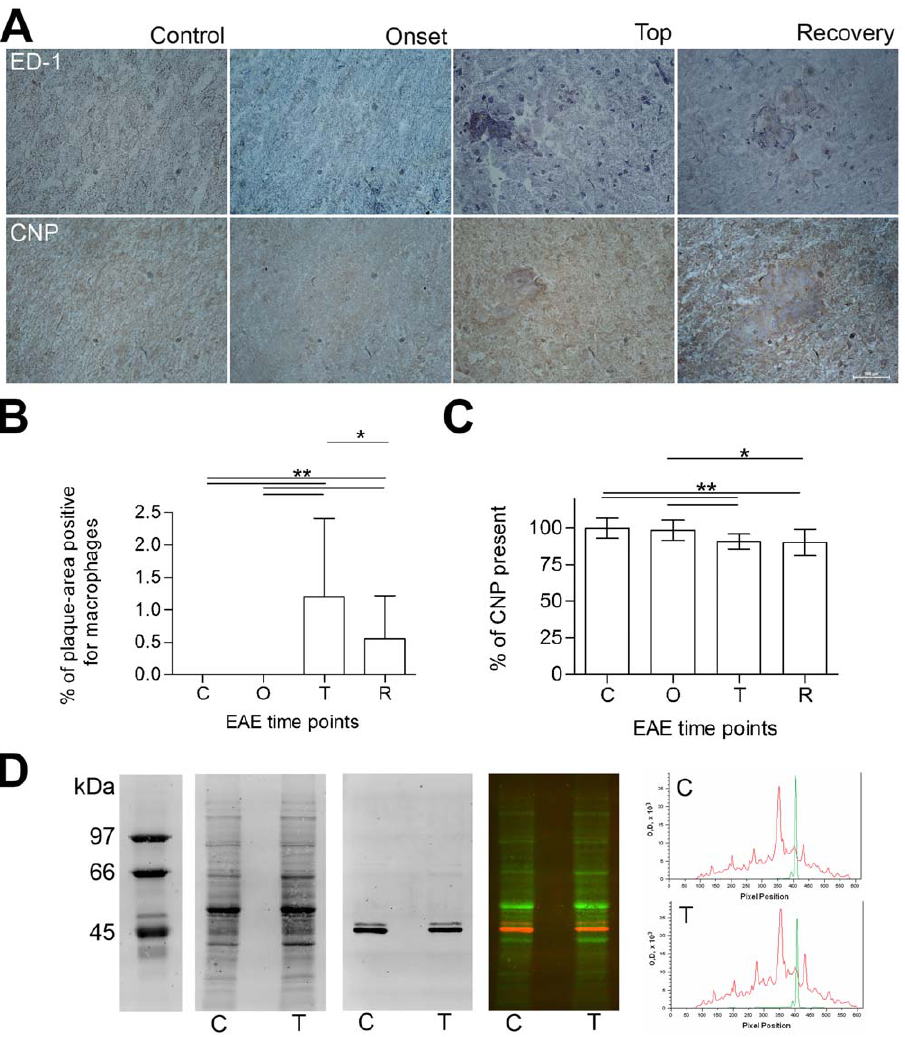
Figure 5. Validation of the 2D-DIGE results. Immunohistochemistry was performed to demonstrate the presence of macrophages and CNP. Macrophage (ED-1) and CNP immunostaining of rat spinal cords (same animals as for 2D-DIGE) from control, and EAE rats before disease onset, top and recovery are shown in panel A. These IHC stainings were quantified (Panel B and C), and expression levels compared by Dunn’s multiple comparison test (GraphPad Prism4). The error bars indicate standard deviations of measurements performed at least in triplicate. *: significant difference, p , 0.01 and **: significant difference, p , 0.001. In Panel D, a quantitative 1D CNP immunoblot of EAE brainstem homogenate from control and disease top is shown. An overview of the fluorescent total protein staining, anti-CNP immunostaining, the fluorescent overlay of both (red and green overlay), and finally a representation of the fluorescent signals as processed with ImageQuant TL software (GE Healthcare). The red curve corresponds with the total protein content and the green curve with the CNP fluorescence. Both a representative control animal (c) and one at the disease top (t) are presented.